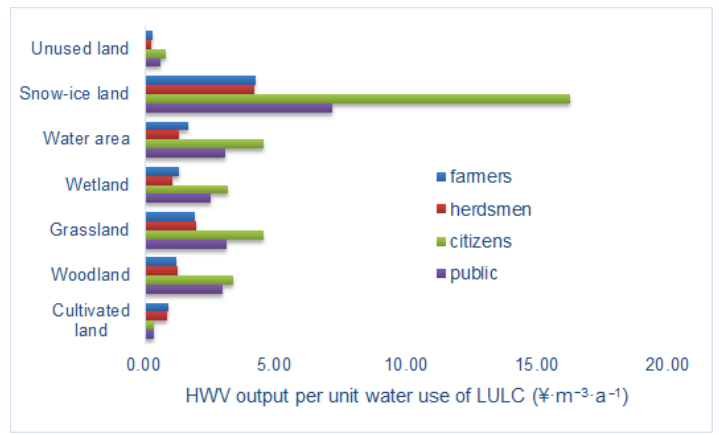
Figure 10. Water use efficiency of LULC for the HWV of stakeholders in the basin.